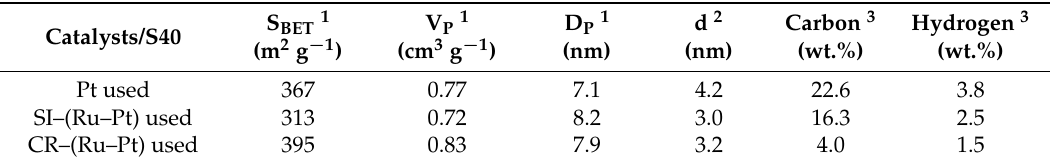
Figure 7. TEM images of catalysts after the test of sorbitol transformation: ( a ) used Pt/S40, ( b ) used SI–(Ru–Pt)/S40, ( c ) used CR–Ru–Pt)/S40. Table 4. Characteristics of the SI–(Ru–Pt)/S40 and CR–(Ru–Pt)/S40 bimetallic catalysts, as well as the Pt/S40 sample, after the catalytic test of sorbitol transformation.